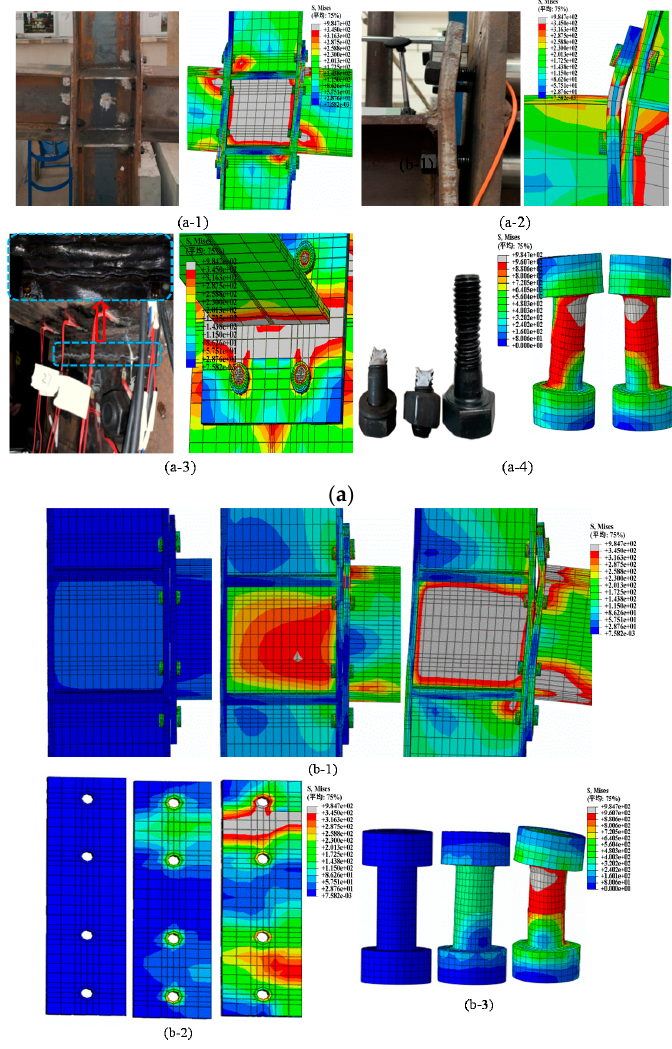
Figure 20. Local deformation and simulation process: ( a ) Comparison of test and finite element; ( b ) Corresponding to 0.01, 0.03, 0.05 rad joint rotation stress contour.